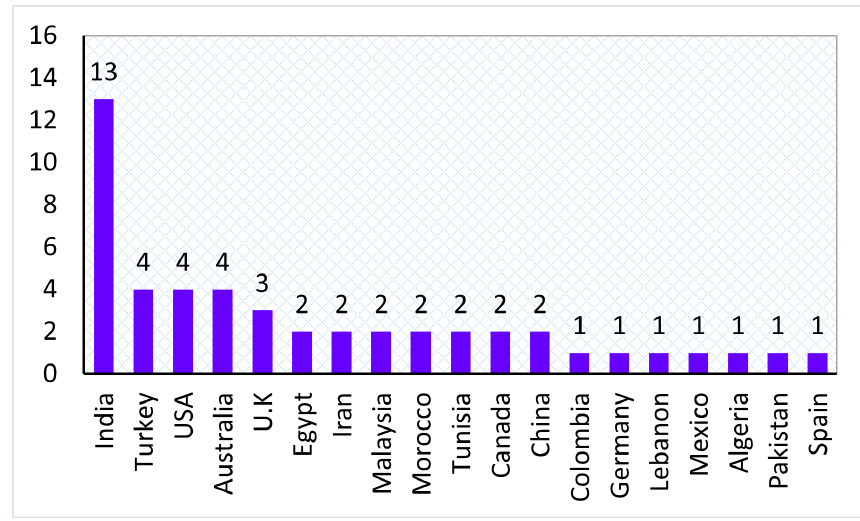
Figure 7. Distribution of studies according to country of